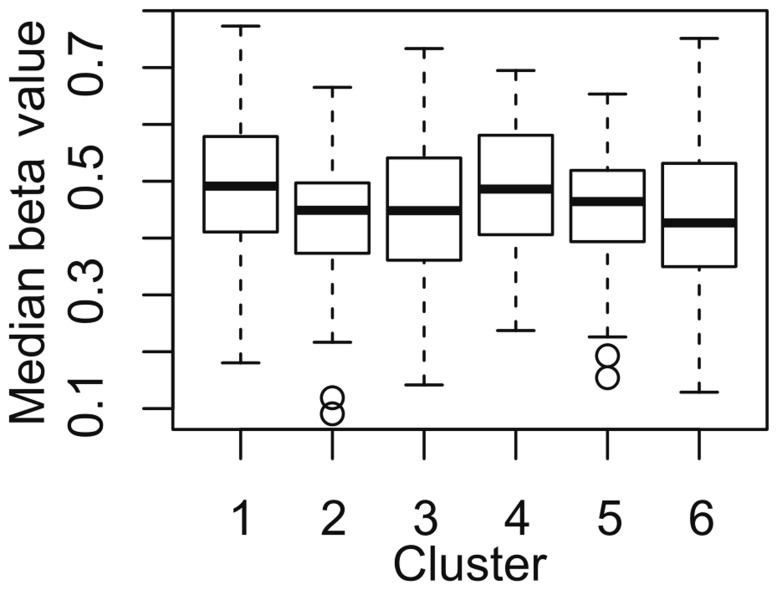
Median beta values of somatic chromosomes.Box plots represent the distribution of median beta values of somatic chromosomes in each cluster. The top and bottom of the box represent the 75th and 25th percentile, the line in the box represents median, the whiskers present minimum and maximum, and the points represent the outliers.